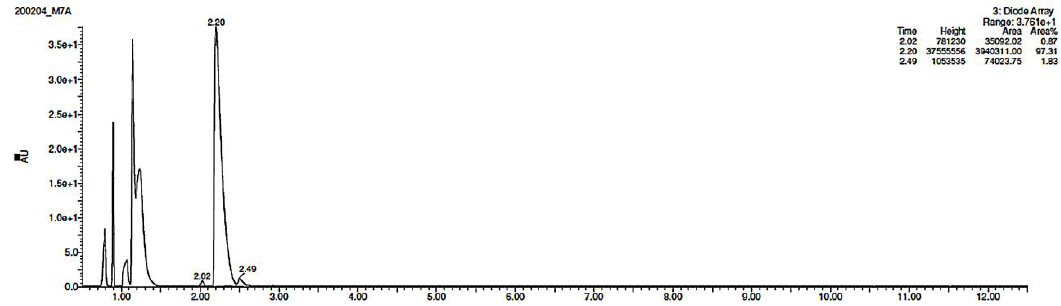
Figure 6. UPLC chromatogram of emedastine (EME) and its degradation products in a solution of pH 3.0.